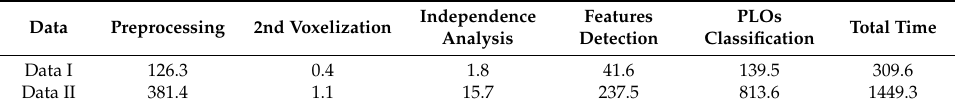
Table 6. Processing time cost by each stage of our method (seconds).